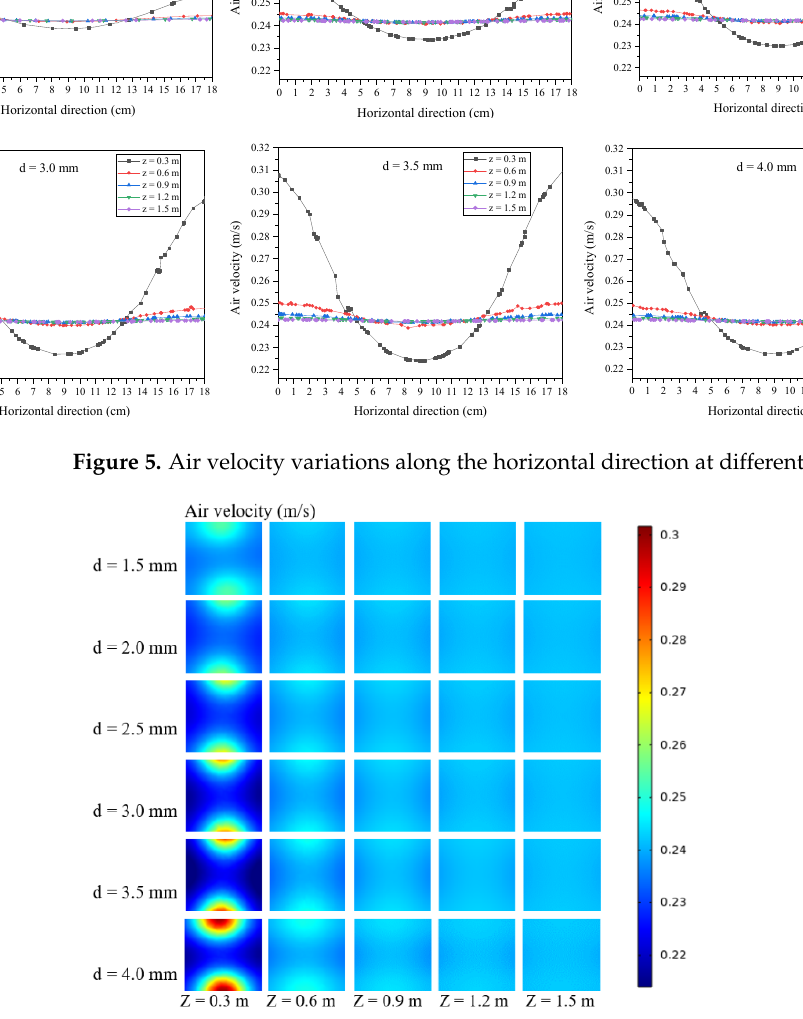
Figure 6. Cloud map of air velocity variations along the horizontal direction at different orifice di- ameters.